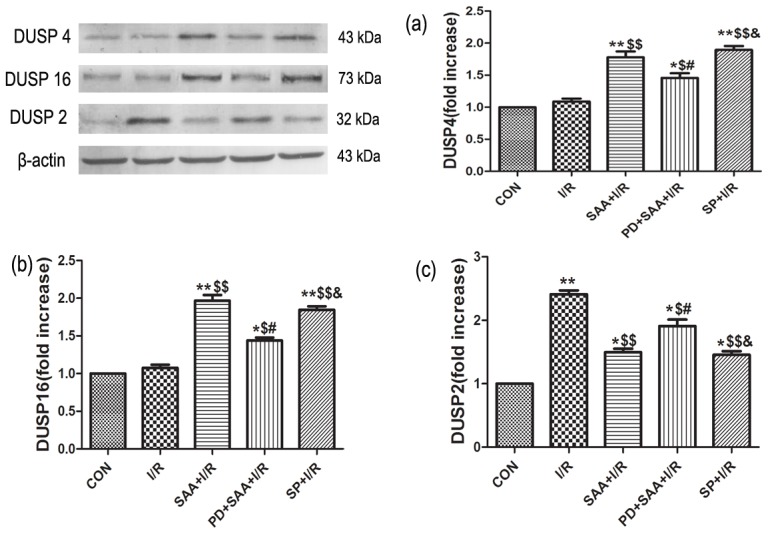
Effects of SAA on DUSP2, DUSP4, DUSP16 during I/R.In the SAA+I/R group, cardiomyocytes were cultivated for 1 h, and I/R was performed after pretreatment with 10 µM for 12 h. In the PD+SAA+I/R group, cardiomyocytes were pretreated with PD for 30 min prior to SAA pretreatment, after incubation with SAA, I/R was performed. In the SP+I/R groups, cardiomyocytes were pretreated with SP for 30 min prior to ischemia, after ischemia, reperfusion was followed. Bar graph a, b, c representative DUSP2, DUSP16, DUSP4 respectively. All data were expressed as mean ±SEM, n = 3, *P<0.05, **P<0.01 versus CON. $P<0.05, $$P<0.01versus I/R. #P<0.05 versus SAA+I/R. &P<0.05 versus PD+SAA+I/R.